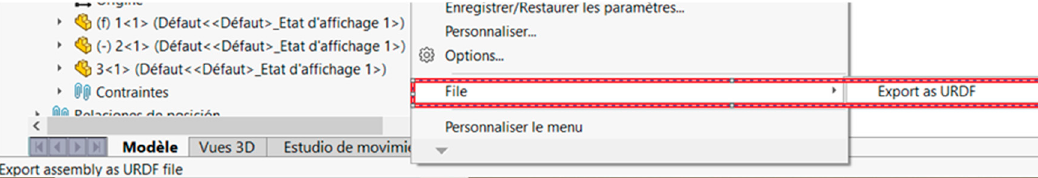
Figure 8. Generating a URDF file in SolidWorks.